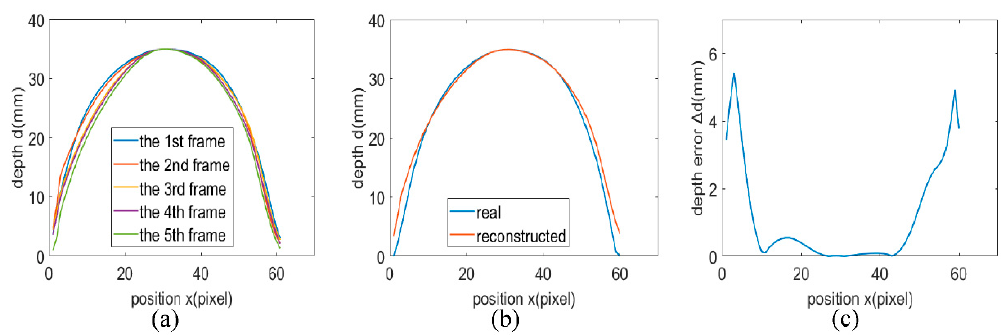
Figure 8. ( a ) Reconstructed depth distributions of rows in five consecutive frames. ( b ) Average reconstructed depth distribution versus true values at the row that crosses the center the hemisphere and ( c ) the corresponding depth error distribution.